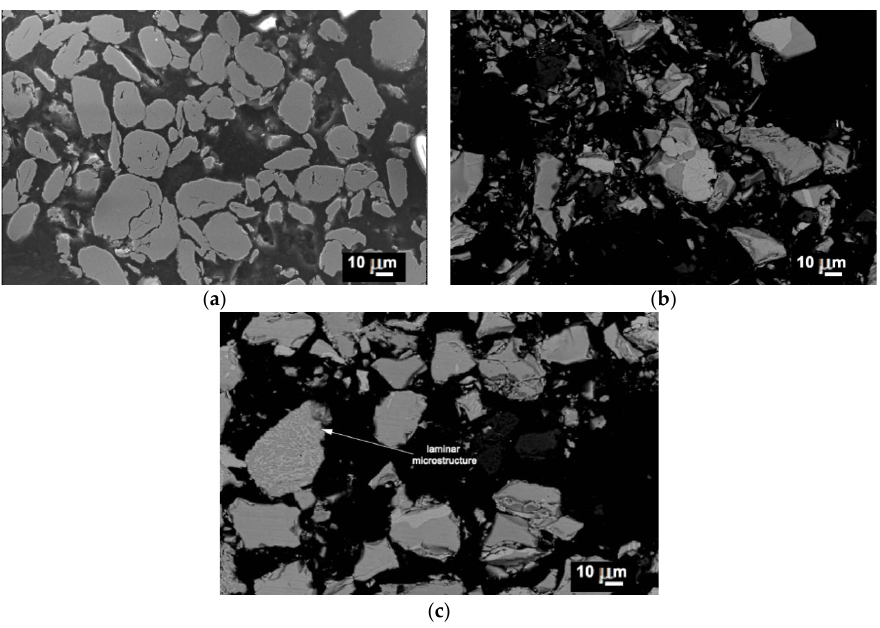
Figure 2. Cross sections of: ( a ) powder 1, ( b ) powder 2, and ( c ) powder 3.